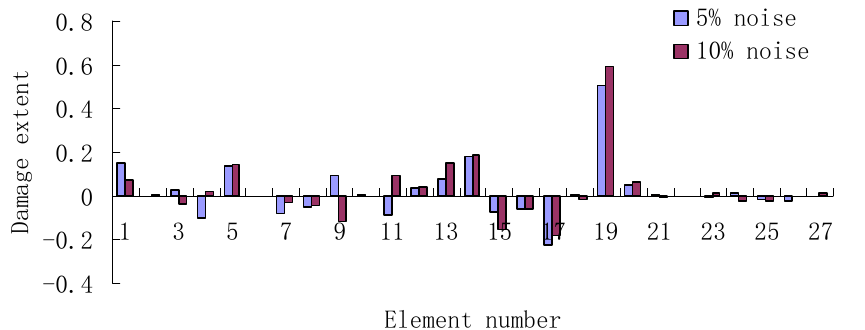
Figure 6. The calculated damage extents by the generalized flexibility method when elements 14 and 19 are damaged.